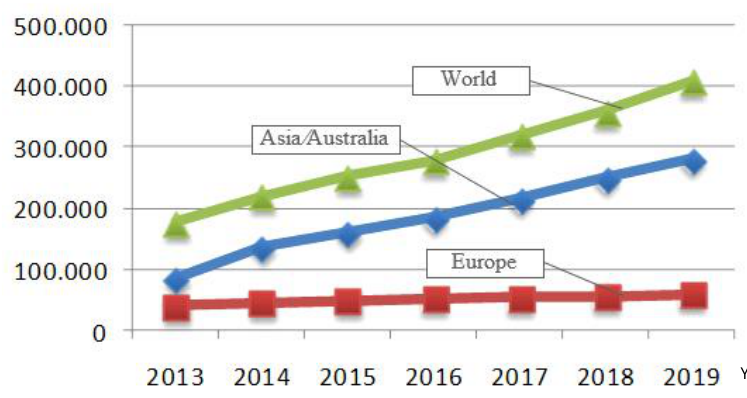
Fig. 8: The representation of industrial robots by continents per 1.000.000 inhabitants for the period 2012-2015 (Karabegović and Doleček, 2014; Karabegović and Husak, 2016; Rochricht, 2016) inh .